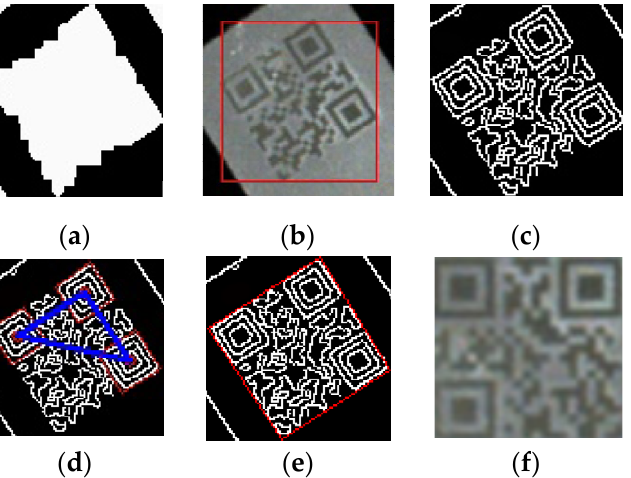
Figure 13. Images depicting the QR code localization process: ( a ) image of a morphological closed operation, ( b ) result of coarse localization, ( c ) image of edge detection by a Canny operator, ( d ) image showing the process of locating three position detection patterns, ( e ) image of precise localization, and ( f ) result of localization.